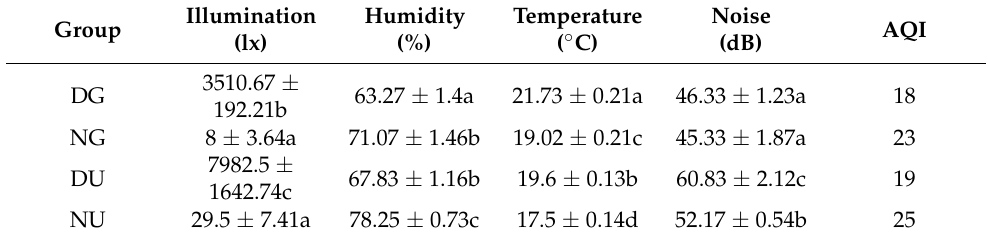
Table 3. The environmental parameters in the experiment. Group